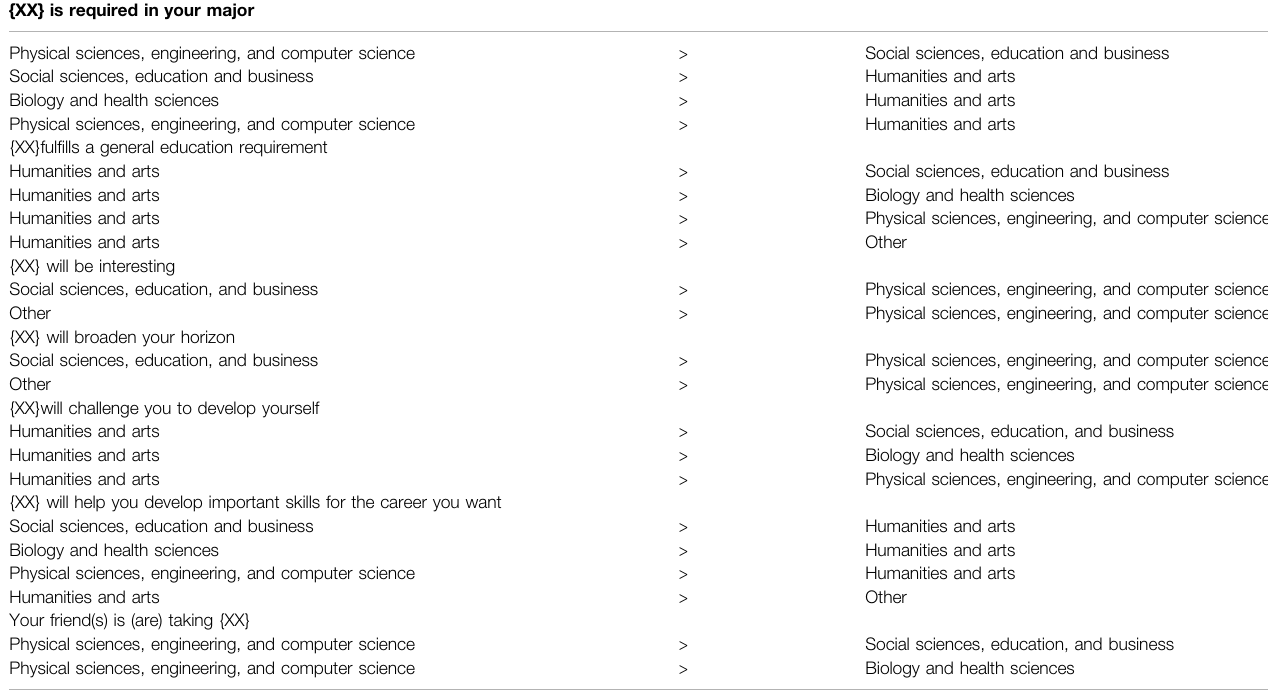
TABLE 1 | Endorsement of course choice reasons for course